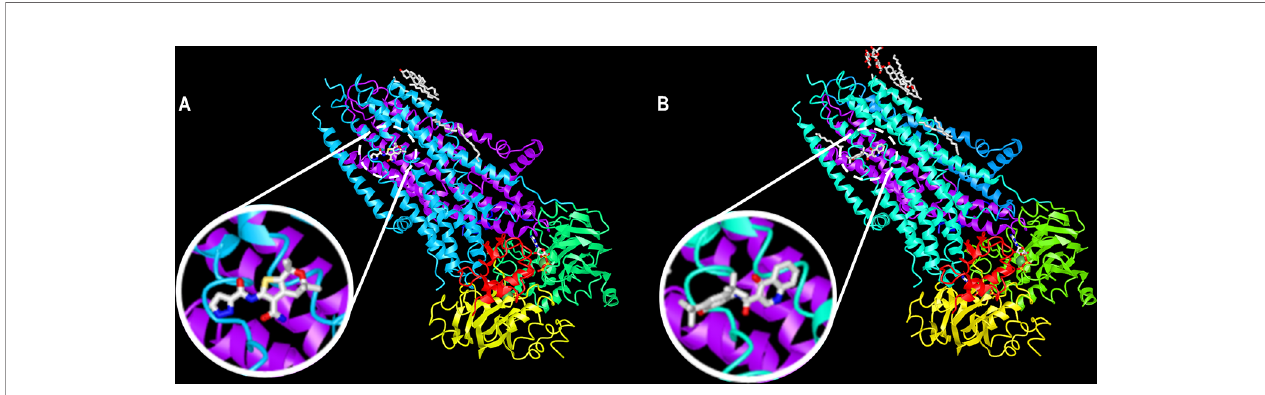
FIGURE 7 | A common binding site for ABBV-974 and ivacaftor. Ribbon diagram of the phosphorylated, ATP-bound CFTR in complex with (A) ABBV-974 and (B) ivacaftor. These structures have been deposited on the Protein Data Bank under accession codes 6O1V (CFTR-ABBV-974) and 6O2P (CFTR-ivacaftor). (adapted from Liu F. et al., 2019 with permission from Prof.